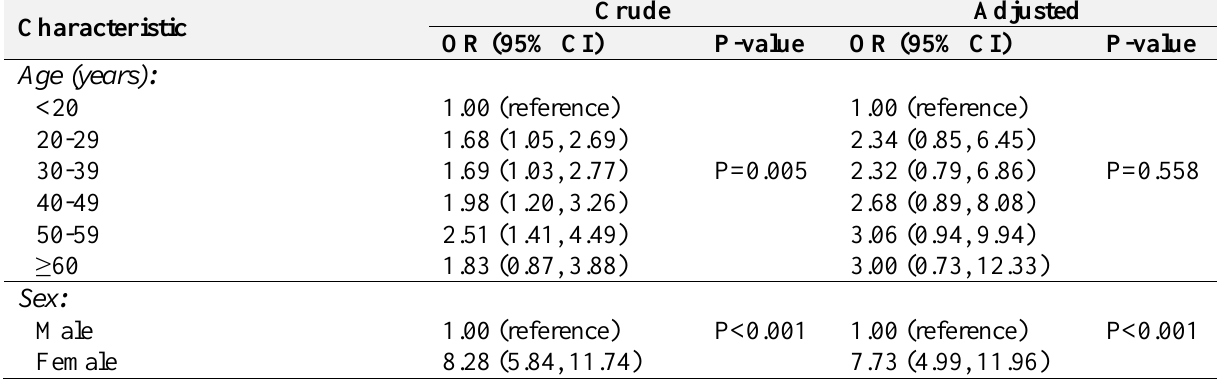
Table 3. Relative odds of practising geophagia based on background characteristics